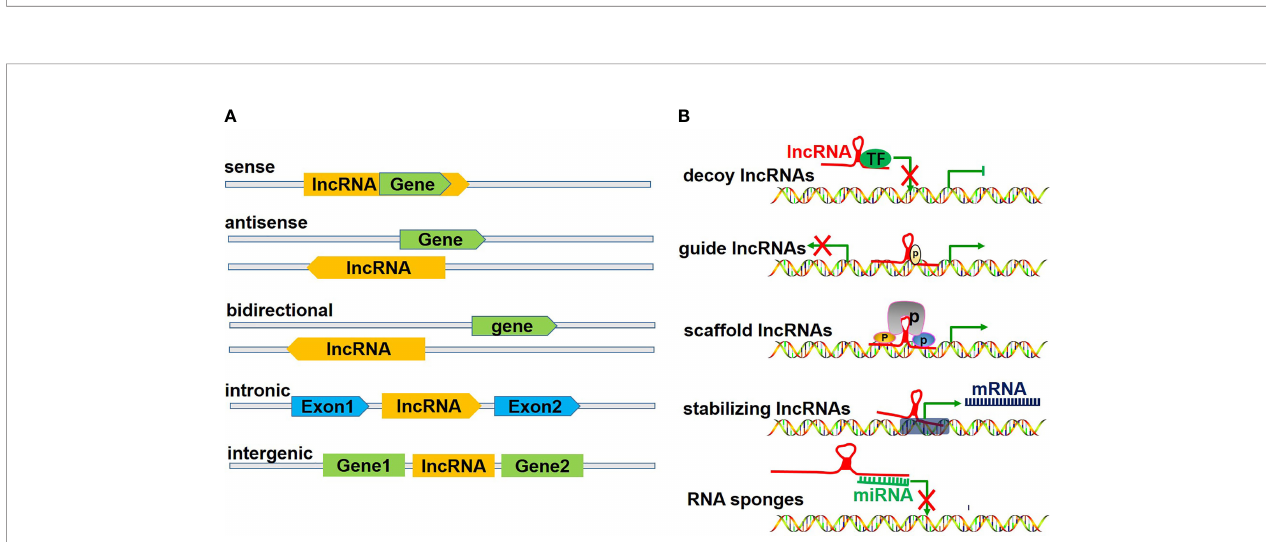
FIGURE 1 | Changes in the EMT markers. This fi gure illustrates that when tumor epithelial cells develop EMT, epithelial markers decrease and mesenchymal markers increase. Epithelioid cell markers include E-cadherin, b -catenin, claudin-1, and zona occludens 1 (ZO-1). Mesenchymal cell markers include vimentin,